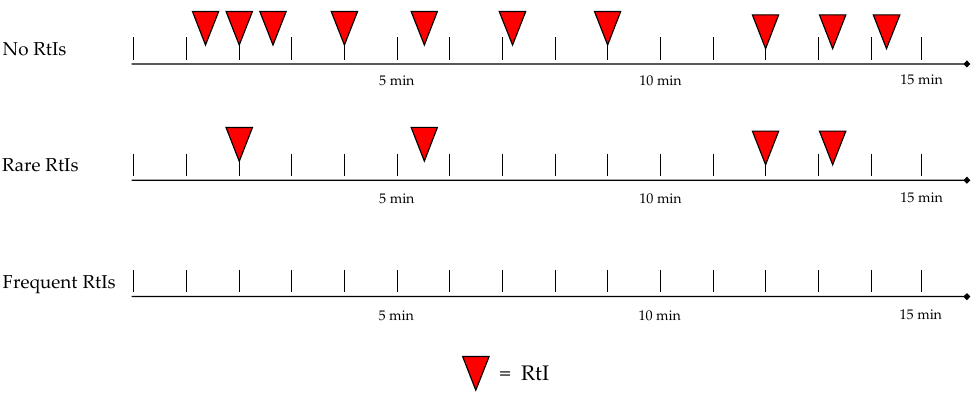
Figure 2. Graphical representation of different RtI frequencies in the three separate experimental drives.